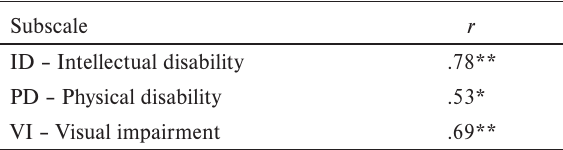
Specific subscale data for the test-retest reliability (N =